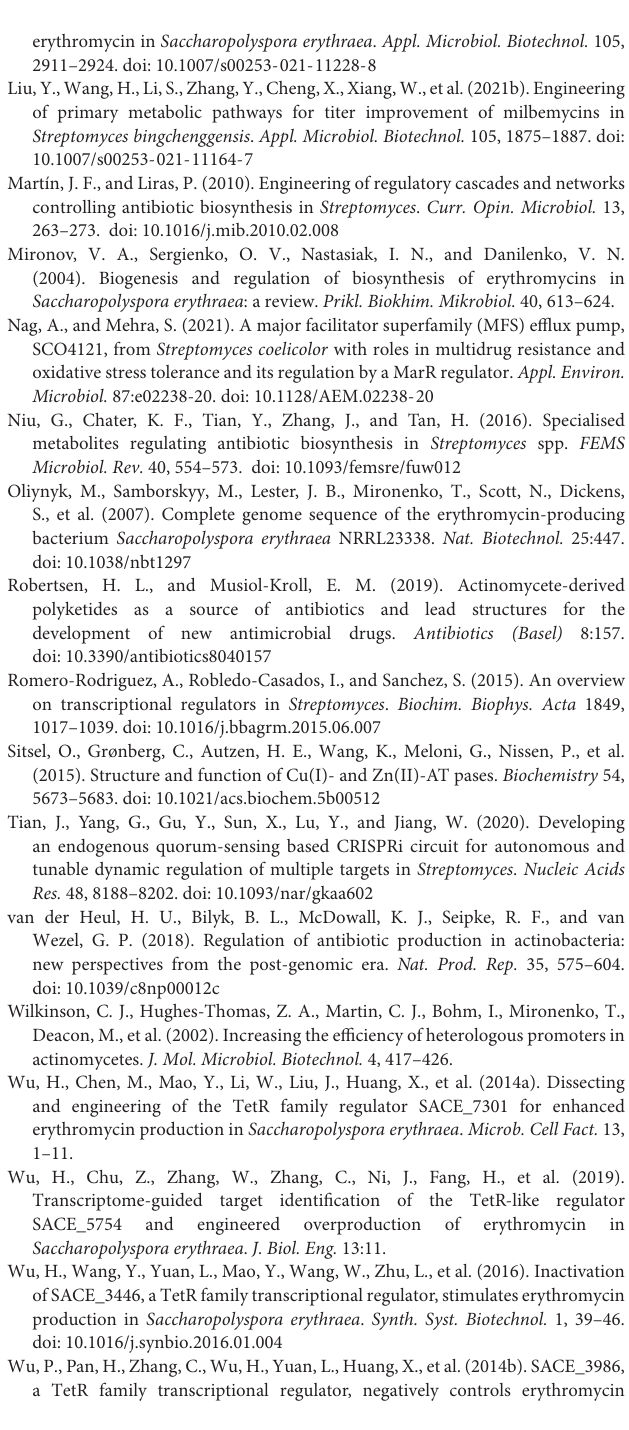
Supplementary Table 1 | Strains used in this study. Supplementary Table 2 | Plasmids used in this study. Supplementary Table 3 | Primers used in this study. Supplementary Table 4 | EMSAs for upstream regions of putative SACE_0303 target